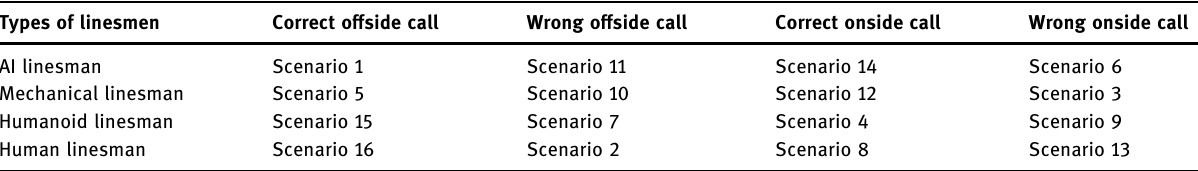
Table 1: Type of linesman and call for each scenario Types of linesmen